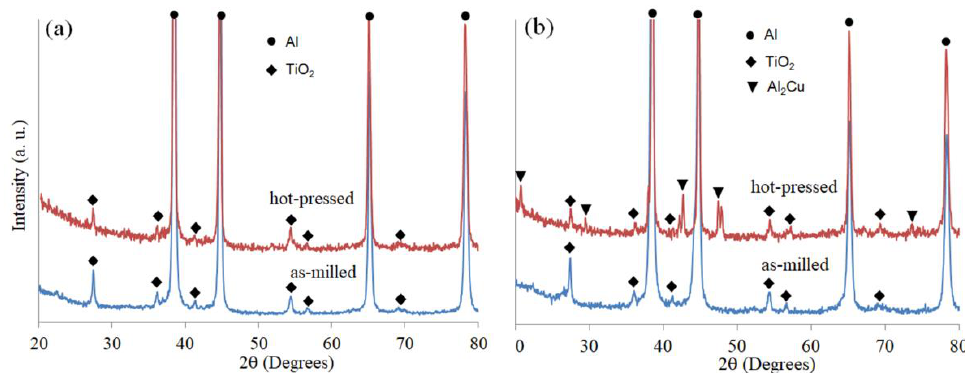
Figure 4. XRD patterns of as-milled and hot-pressed composites with ( a ) 2% stearic acid and ( b ) 5% Cu.